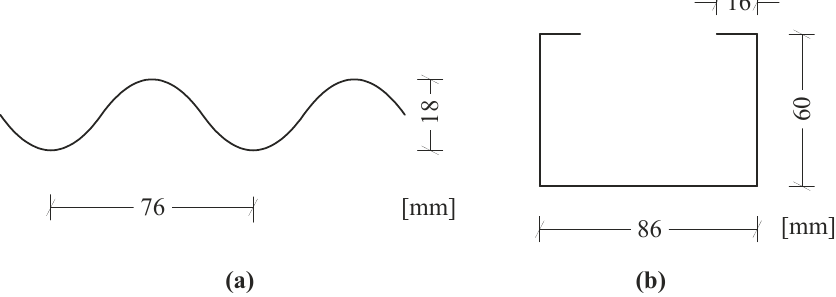
Figure 1. Dimensions of silo cross-sections: ( a ) corrugated sheet (silo wall); ( b ) cold-formed channel section (columns).